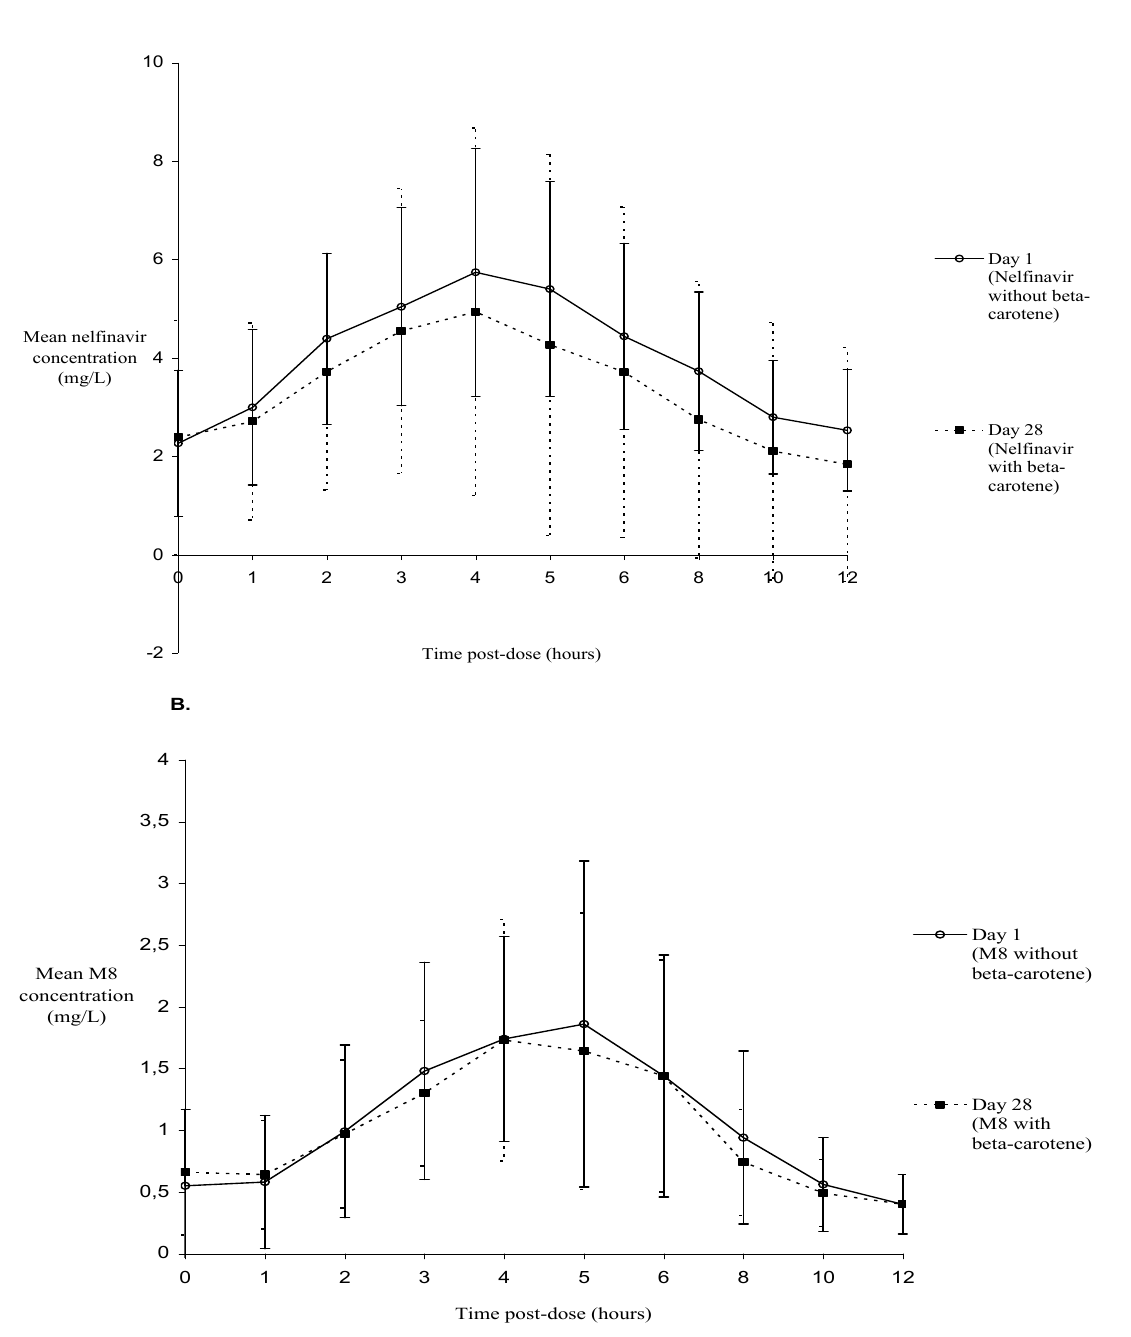
Figure 1. Mean nelfinavir (A, n = 11) and M8 metabolite (B, n = 9) plasma concentrations (mg/L) before and after 28 days of β -carotene